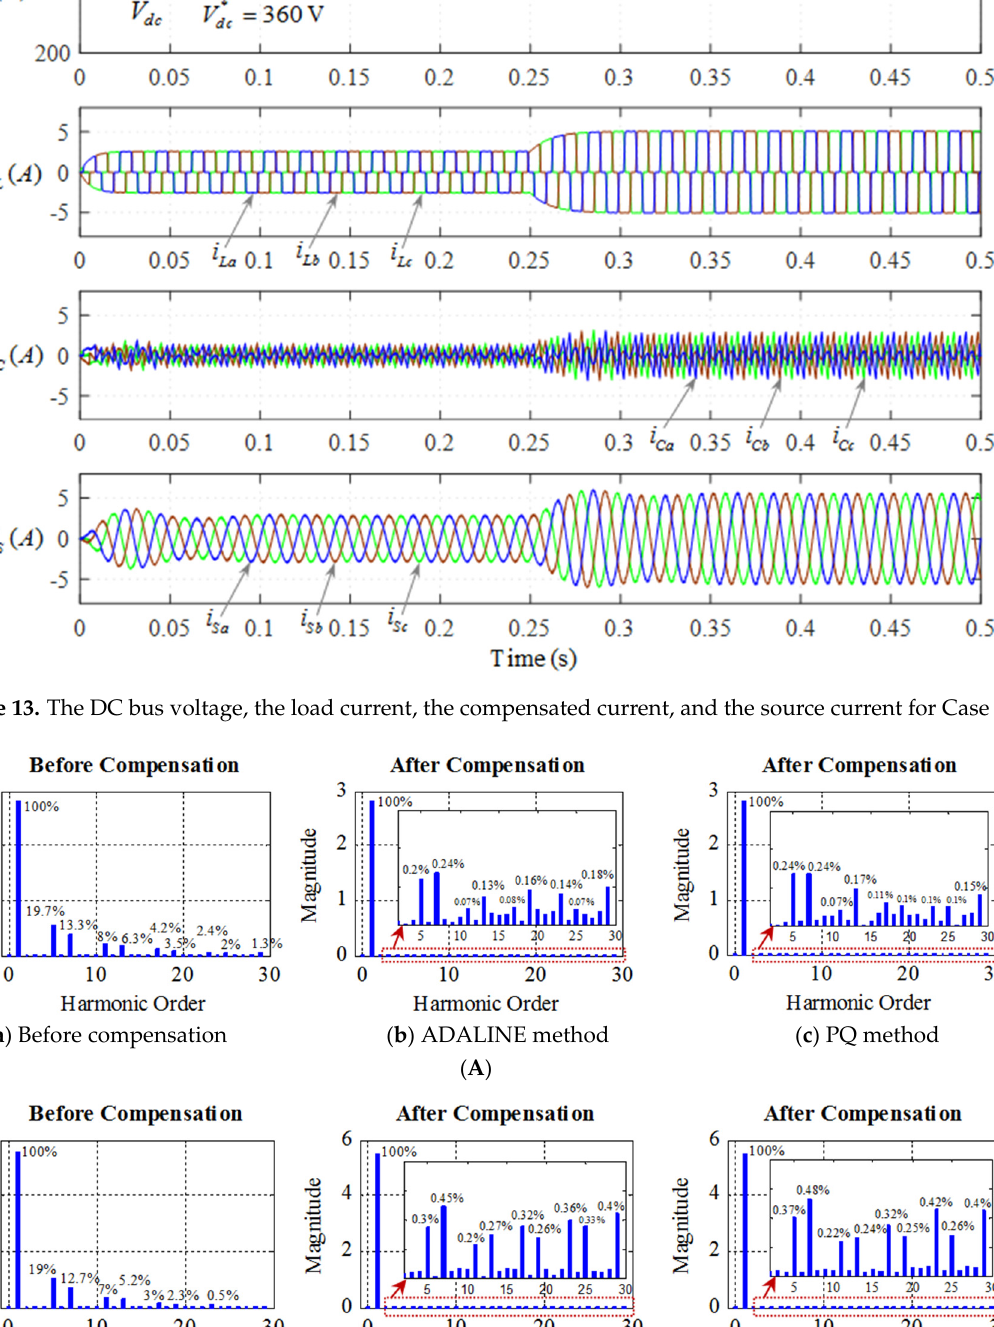
Table 4. The average performance value for Case 3.